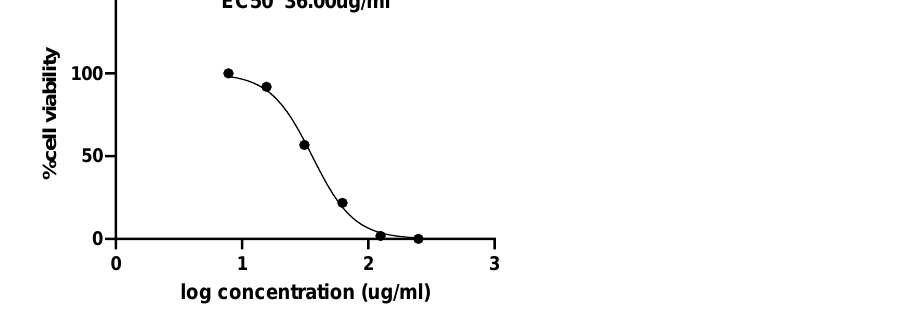
Figure 4. Cytotoxic effect of 4/5 against the oral squamous carcinoma cell line after 48 h of incuba- tion.